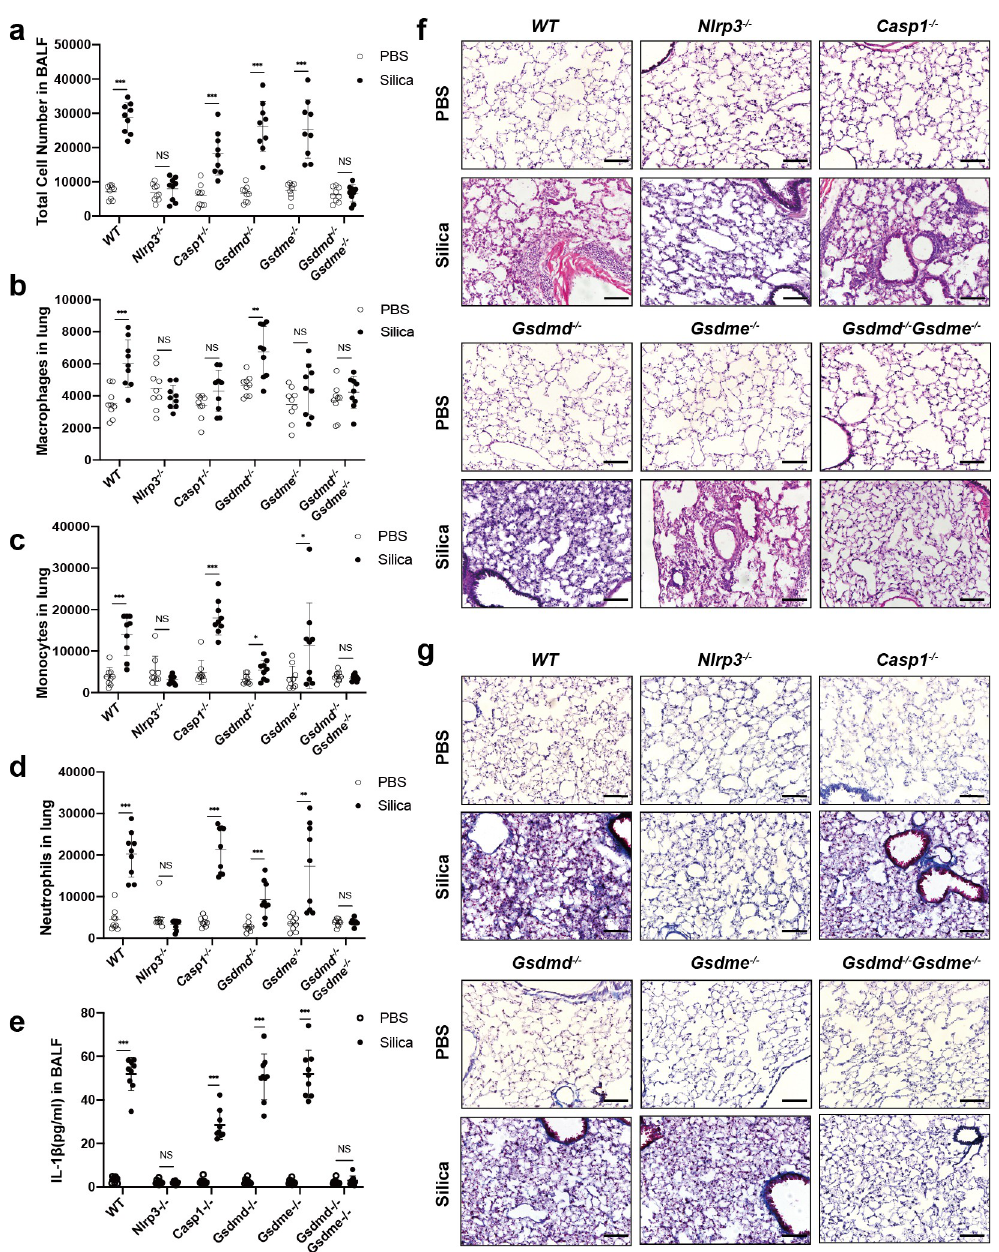
Fig 2. In vivo instillation of silica induced pulmonary inflammation alleviates in Gsdmd -/- Gsdme -/- mice. a The number of cells in the BALF of WT , Nlrp3 -/- , Caspase-1 -/- , Gsdmd -/- , Gsdme -/- and Gsdmd -/- Gsdme -/- mice 14 days after exposure to PBS or silica, n = 3. b-d The number of macrophages ( b ), monocytes ( c ) and neutrophils ( d ) in whole lung tissues, n = 3. e IL-1 β in the BALF of WT , Nlrp3 -/- , Caspase-1 -/- , Gsdmd -/- , Gsdme -/- and Gsdmd -/- Gsdme -/- mice 14 days after exposure to PBS or silica, n = 3. f, g H&E ( f ) and Masson ( g ) staining of mouse lung sections 2 months after the initial challenge. The scale bar represents 100 μ m. Results are expressed as mean ± SD from three independent experiments. NS, not significant; � P < 0.05, �� P < 0.01 and ��� P <